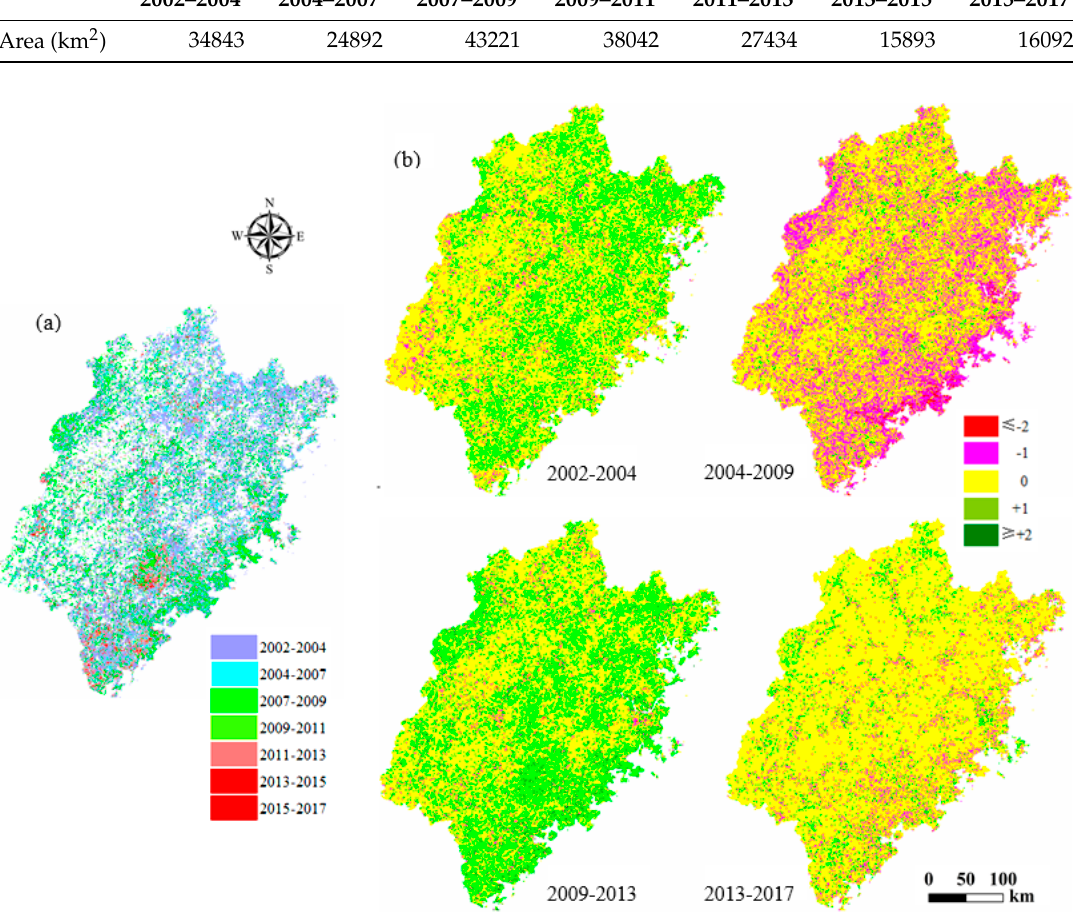
Figure 6. Change detection maps showing ecological status changes in various durations. ( a ) Time-series change detection mostly at a two-year interval, and ( b ) RSEI level-based change detection in four durations.